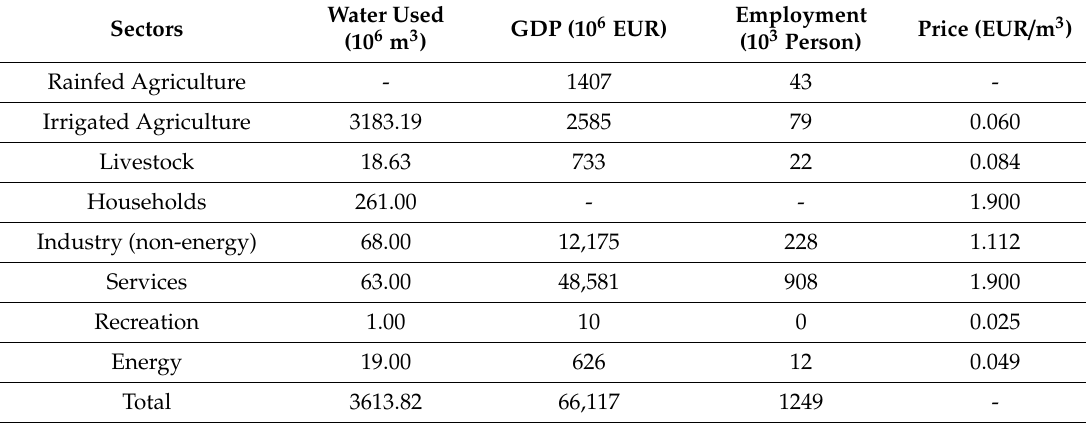
Table 1. Characterisation of the economic sectors in the basin. Guadalquivir